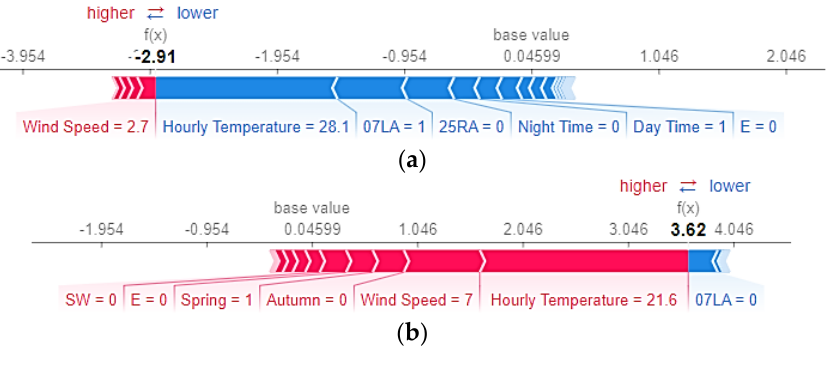
Figure 13. SHAP explanatory force plots: ( a ) plot of case with a value equal to 0.291; ( b ) plot of case with a value equal to 3.62.